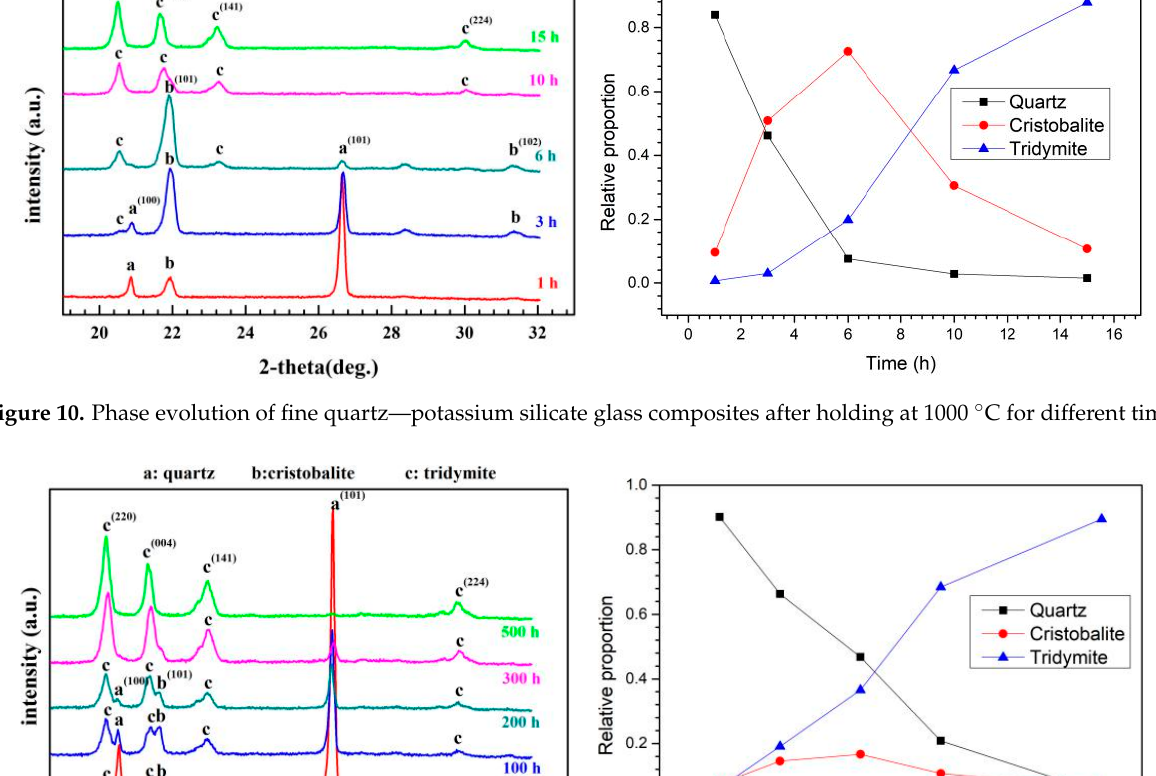
Crystals 2021 , 11 , x FOR PEER REVIEW